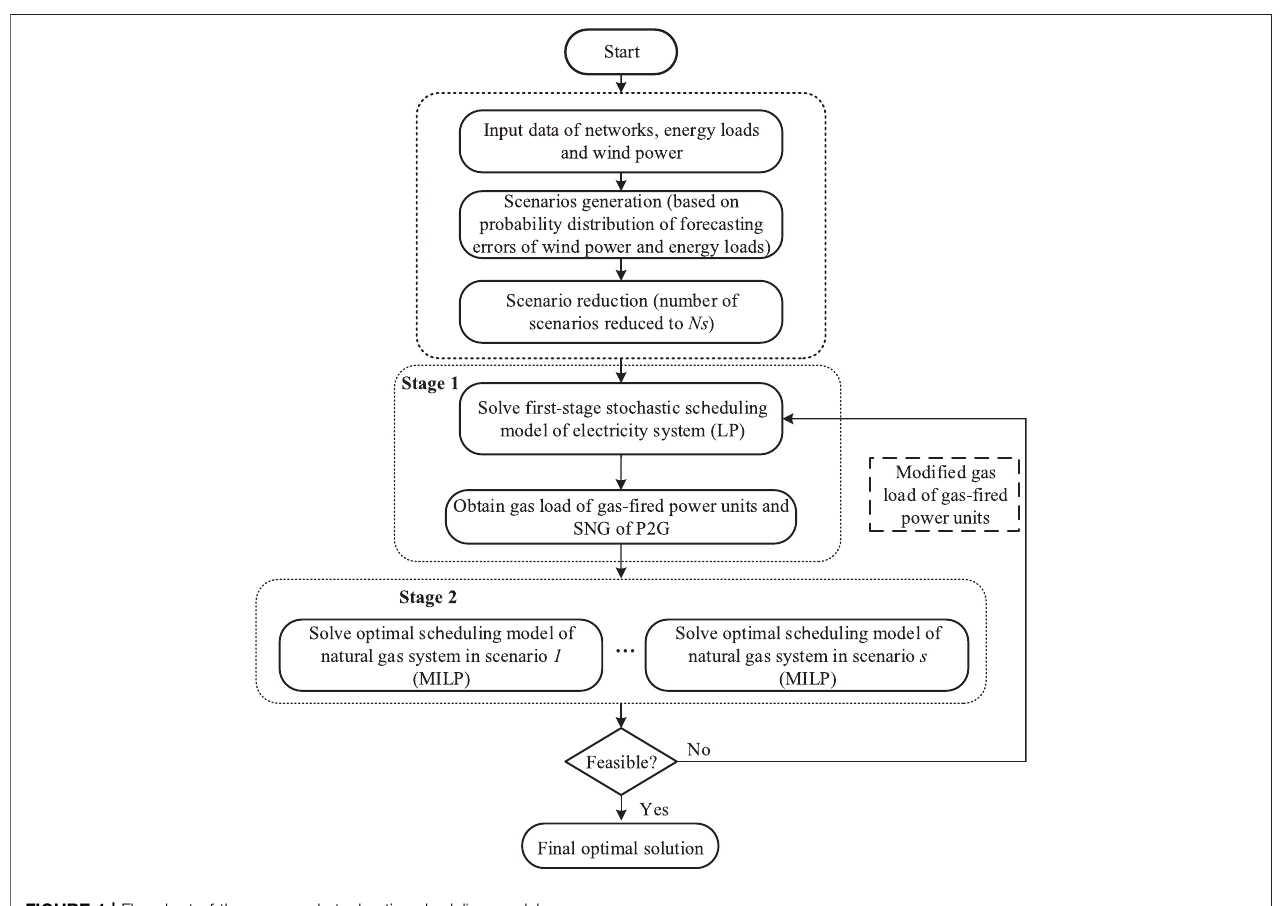
FIGURE 1 | Flowchart of the proposed stochastic scheduling